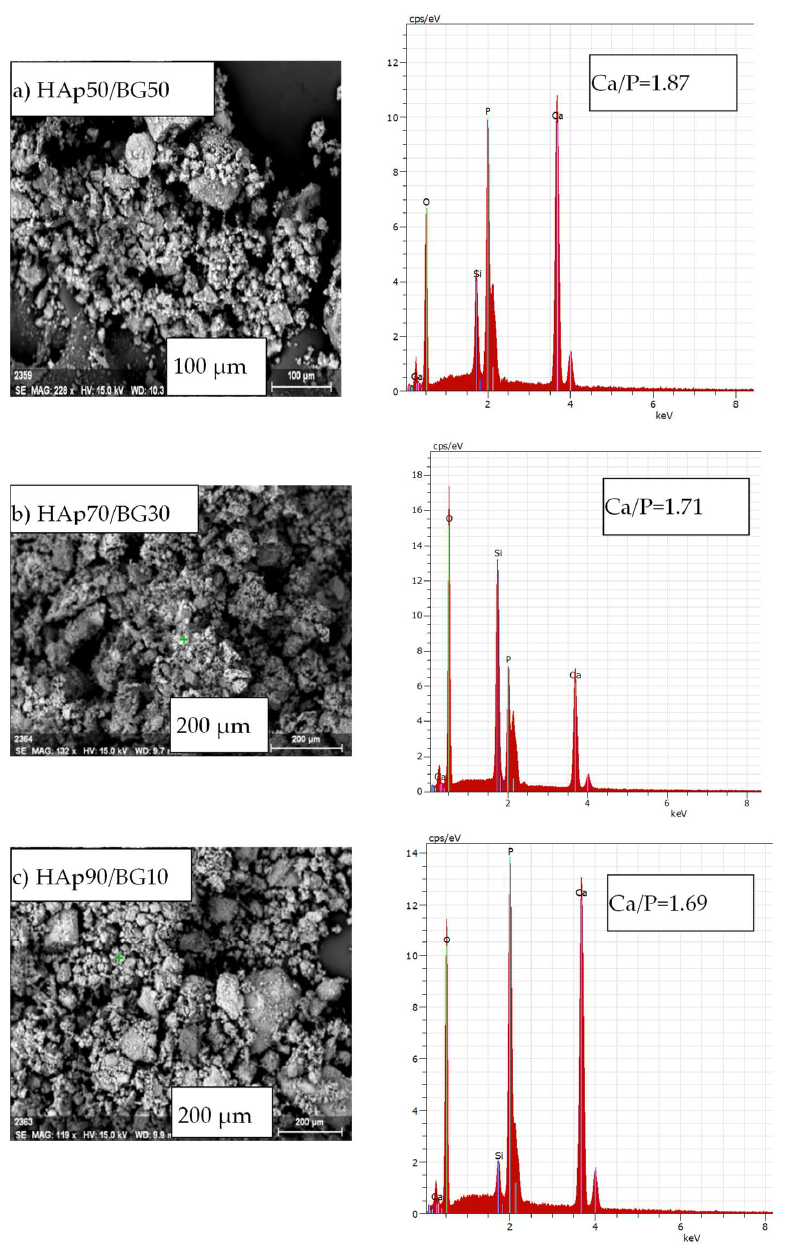
Figure 5. SEM and EDX results of HAp/BG composite nanopowders with three different weight ratios at 180 °C.